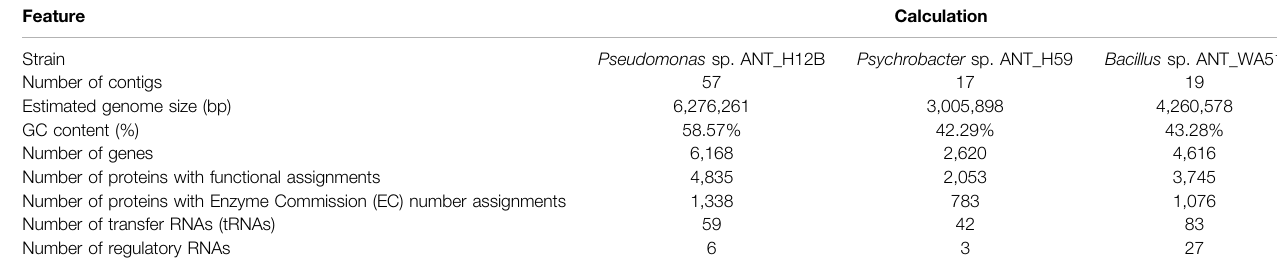
TABLE 1 | General features of the Pseudomonas sp. ANT_H12B, Psychrobacter sp. ANT_H59 and Bacillus sp. ANT_WA51 draft